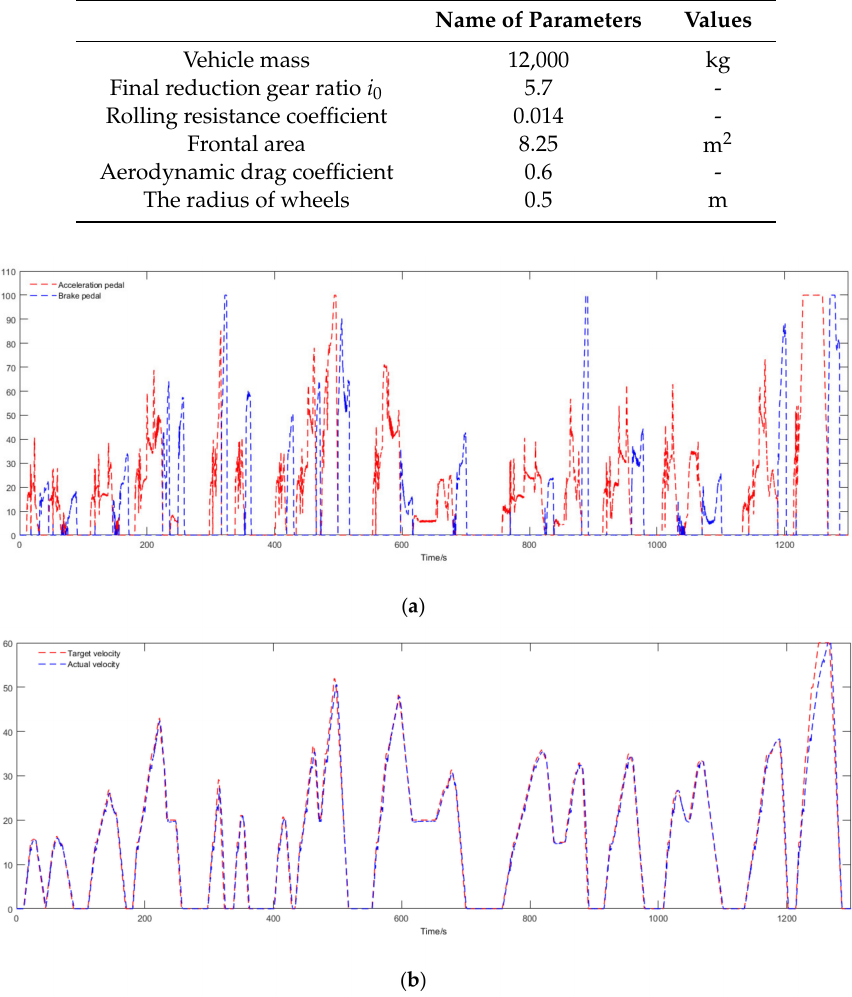
Figure 17. Curve of the experiment: ( a ) Pedal and ( b ) Velocity.